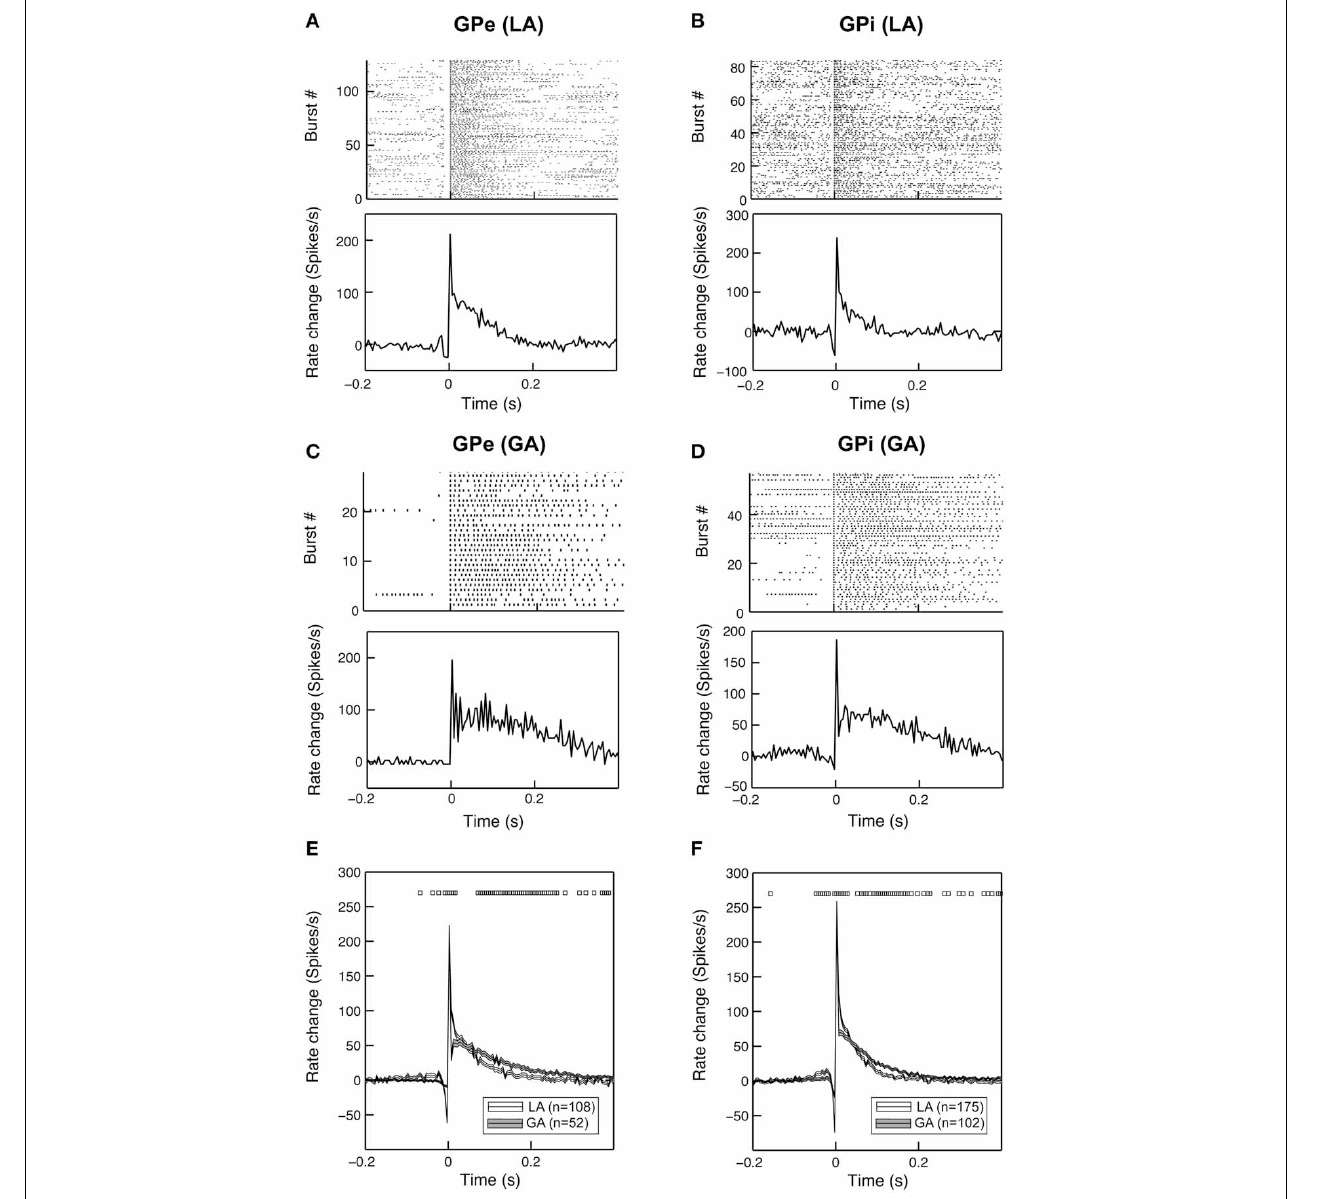
FIGURE 4 | Bursting properties of pallidal neurons recorded under GA differ from those recorded during awake surgery. Representative examples of peri-burst analyses for neurons recorded from the GPe (A,C) and GPi (B,D) in LA and GA. The top panels depict peri-burst raster plots (aligned on burst onset). Bottom panels show mean peri-burst time histograms across all bursts following the subtraction of the cell’s mean firing rate between − 300 and − 100ms prior to burst onset. (E,F) Grand